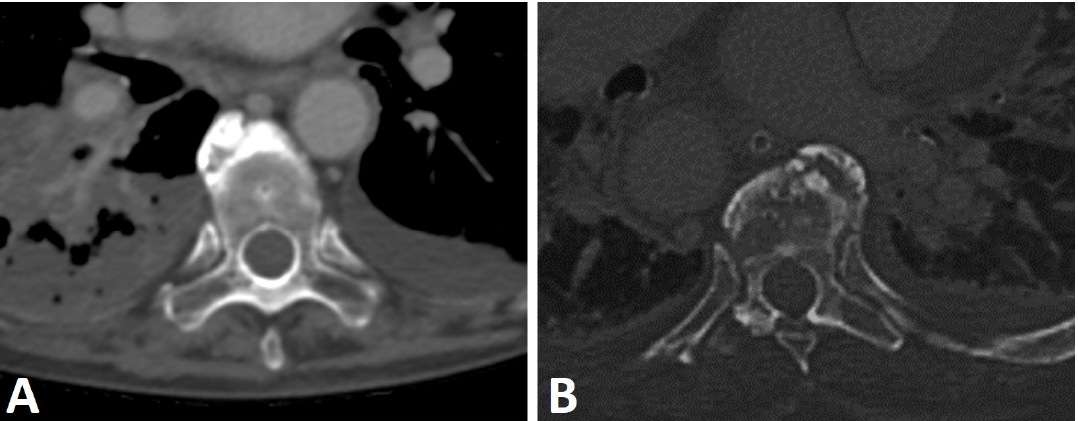
Figure 5. Axial CT images of two patients with thoracic DISH (not shown). ( A ) left-sided and ( B ) right-sided aortas with an anterior osteophyte located contralateral to the aorta’s position.